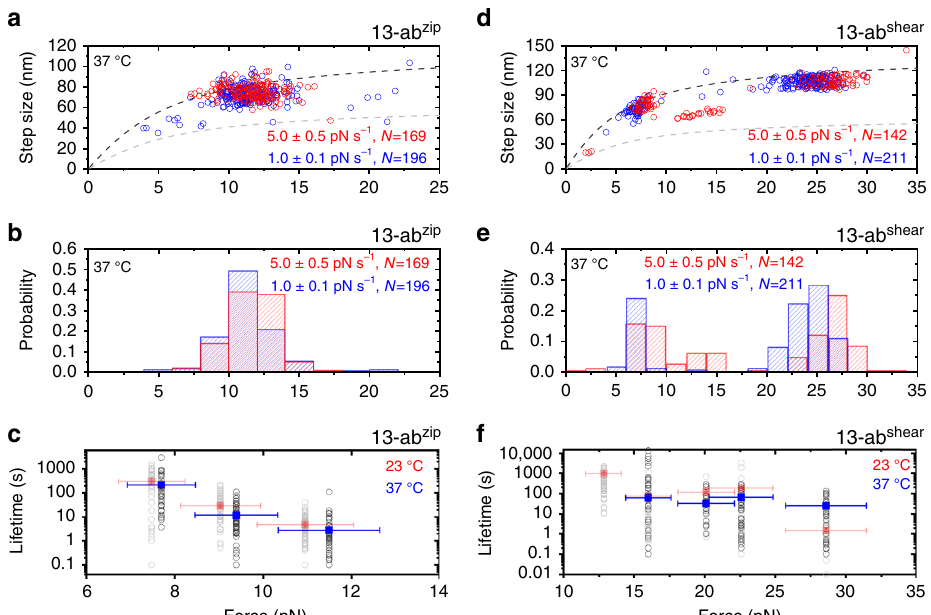
Fig. 3 Temperature-dependent mechanical stability of helix-heterotetramers. a The force – step size graph of the force-dependent rupturing (unlooping) transitions of the 13-ab zip obtained at 37 °C. The dash curves are theoretically predicted. b Normalized histograms of the 13-ab zip rupture forces obtained at 37 °C. c Force-dependent lifetimes of the 13-ab zip at 37 °C (blue) and 23 °C (red, same as Fig. 1f). d The force – step size graph of the force-dependent rupturing (unlooping) transitions of the 13-ab shear obtained at 37 °C. The dash curves are theoretically predicted. e Normalized histograms of the 13-ab shear rupture forces obtained at 37 °C. f Force-dependent lifetimes of the 13-ab shear at 37 °C (blue) and 23 °C (red, same as Fig. 2e). For panels a , b , d , and e : the number of data points obtained from >5 independent tethers are indicated. For panels c and f : the solid squares represent the average lifetimes ( τ ) obtained by best- fi tting of the lifetime histogram to a single-exponential decay function. The hollow gray circles represent individual lifetimes ( N ~ 100 for p . The horizontal error bars indicate each force) measured in experiments. The vertical error bars indicate the standard errors of the lifetime obtained by τ ffiffiffiffiffiffiffi N (cid:1) 1 10% of relative force uncertainty resulted from the force-calibration method. Source data are provided as a Source Data fi le.